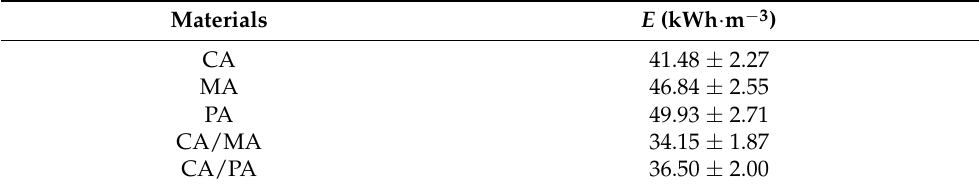
Table 12. Energy densities calculated for the studied materials at pressure p = 0.1 MPa